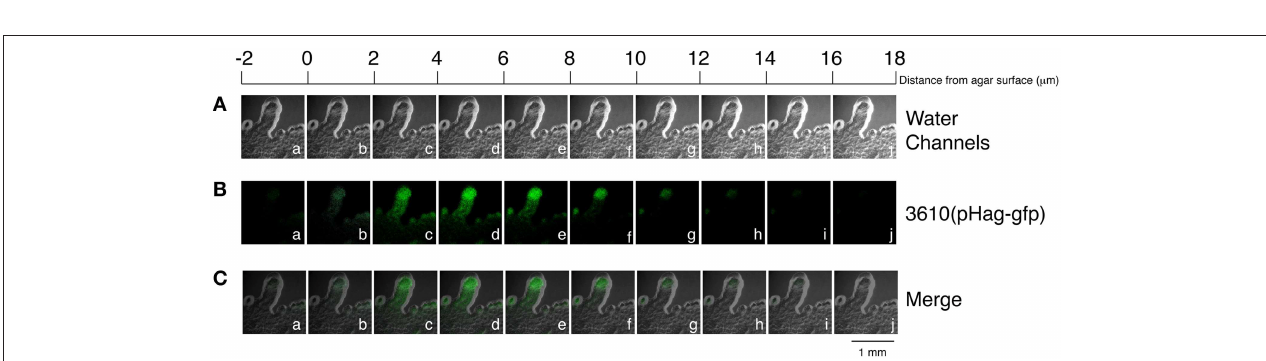
FIGURE 7 | Height of the edge of a colony formed by B. subtilis 3610(pHag-gfp). A z stack, with planes separated by 2 µ m, was acquired from the edges of a B. subtilis 3610(pHag-gfp) colony that had been cultured for 2h on a 25-ml LB-0.7 plate (green) (B) . A z stack was also generated using a visible light to show the edge of the colony (gray) (B) . Merged images of (A) and (B) are shown in (C) .